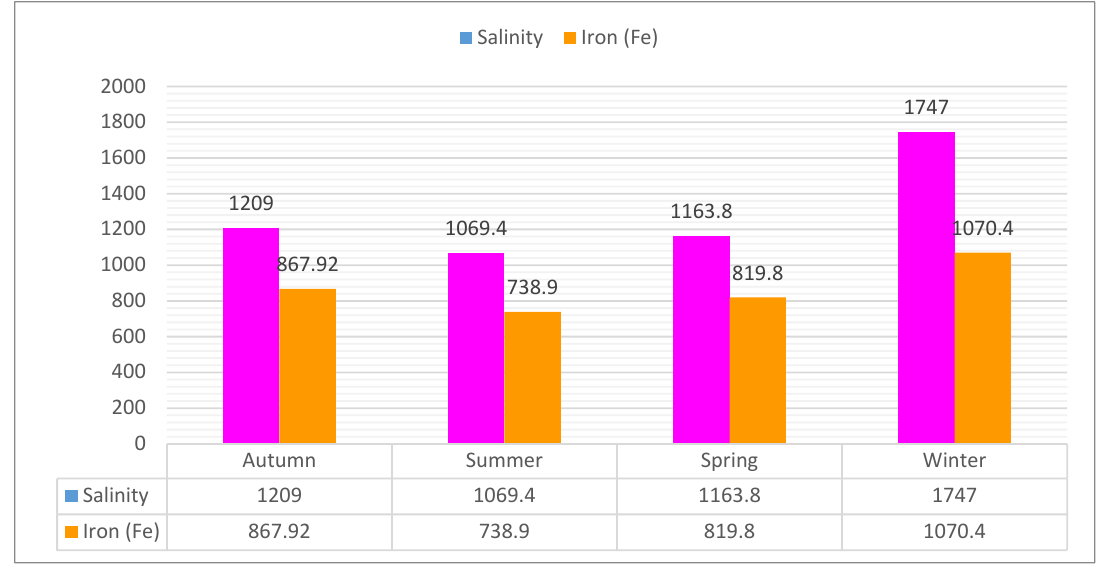
Figure 4. Laboratory measurements for the four seasons of 2017, salinity and iron.